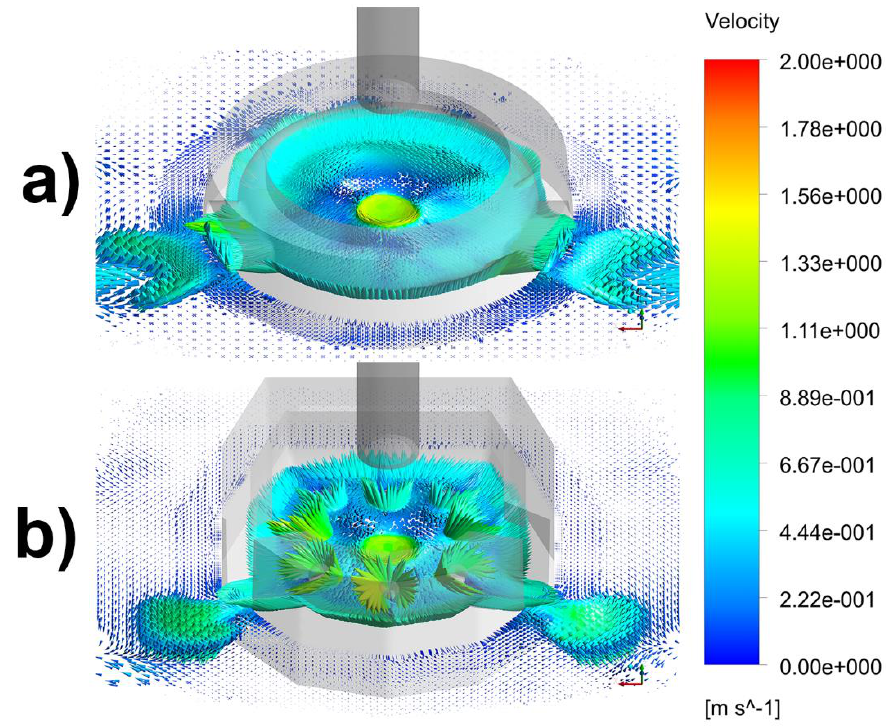
Figure 5. Numerical velocity fields inside the TIs: ( a ) TI1; ( b ) TI3.